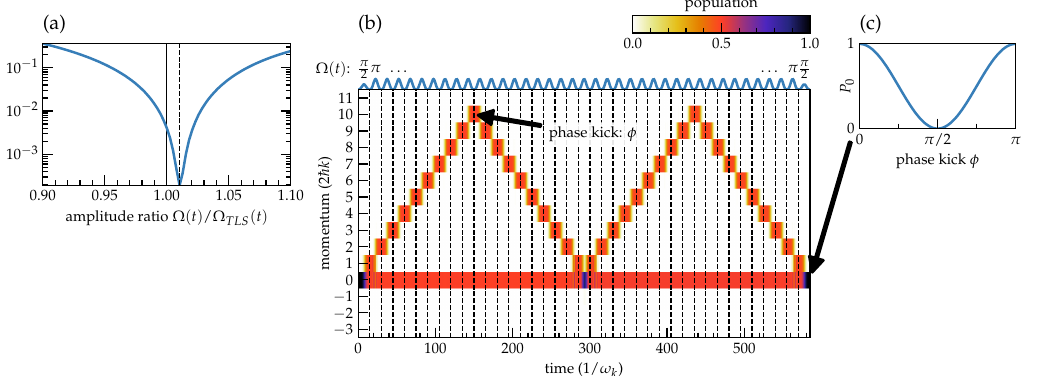
2 of the population in the ground state after a sequence of π /2 and Figure 2. ( a ) Error 1 0 Ψ ( T ) − |(cid:104) | (cid:105)| π pulses for a scaled pulse amplitude. The factor Ω ( t ) / Ω TLS ( t ) is the ratio of the pulse amplitude Ω ( t ) used in the simulation and the analytic amplitude Ω TLS ( t ) for Rabi cycling in a two-level system with a pulse area of π /2 or π , Equation (9). The minimum error is reached for a ratio of 1.01, ≈ indicated by the dashed vertical line. ( b ) Momentum space dynamics for an interferometric scheme using a sequence of π /2 and π pulses. Each pulse has a Blackman shape, drawn at the top of the panel, with an amplitude adjusted by the correction determined in panel ( a ). The time unit 1/ ω k corresponds to roughly 10 − 5 s for Rb-87 atoms and a laser wavelength of 780 nm, making the duration of the scheme (excluding the free time evolution) roughly 5.9 ms. ( c ) The final time population in 0 | (cid:105) if an instantaneous phase kick is applied to the 10 component of the wave function at maximum | (cid:105) separation to account for the free time evolution starting at t = 150 / ω k and t = 450 / ω k (not shown). Subsequent pulses are π -pulses at twice the amplitude of Equation (9) that fully transfer population between neighboring levels, respectively swap the population of 0 |